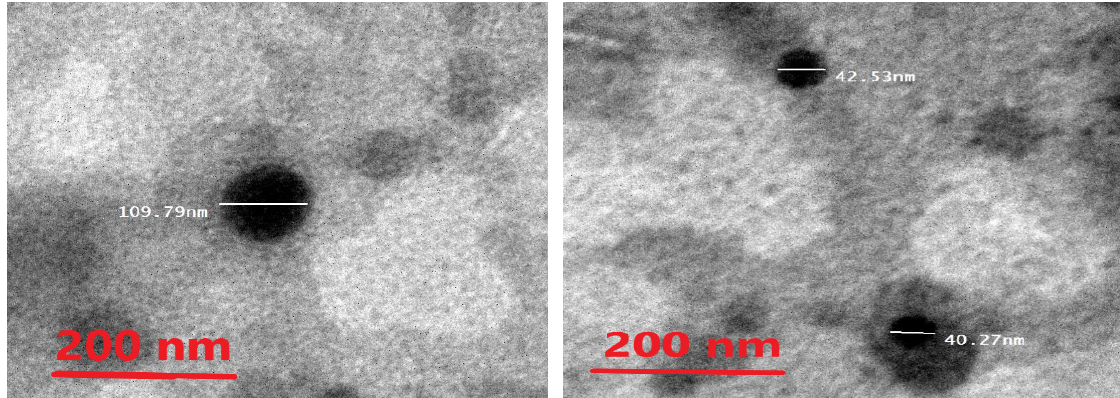
Figure 5. Photomicrograph of the optimal metformin-loaded ethosome formula as seen by the TEM.